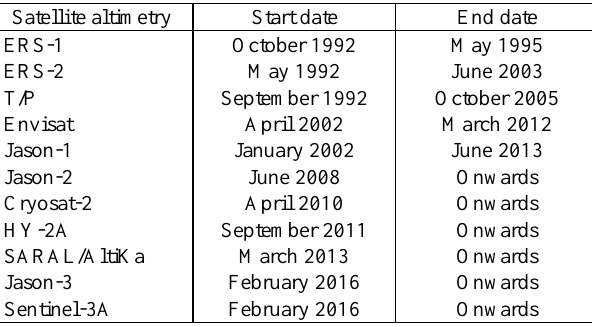
Table 1. Satellite date used in the gridded model